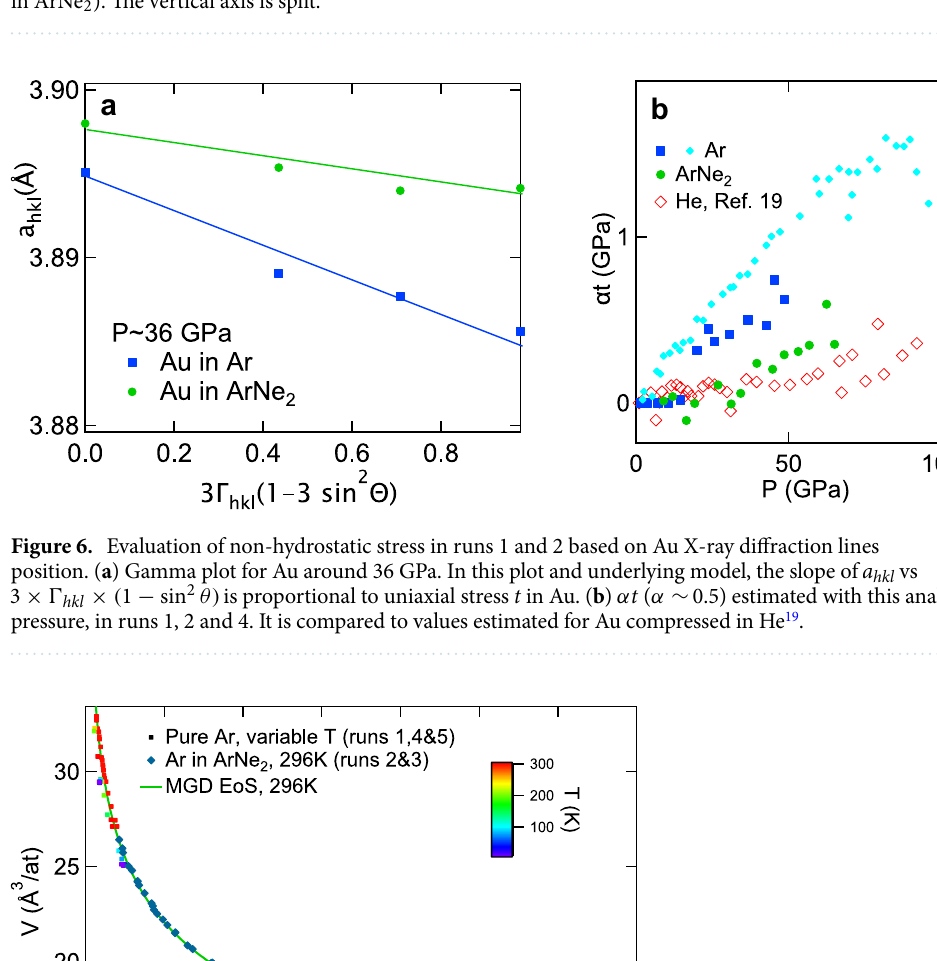
Figure 5. Size of fcc-Ar domains obtained from Rietvelt refinement of XRD data for runs 1 (pure Ar) and 2 (Ar in ArNe 2 ). The vertical axis is split.